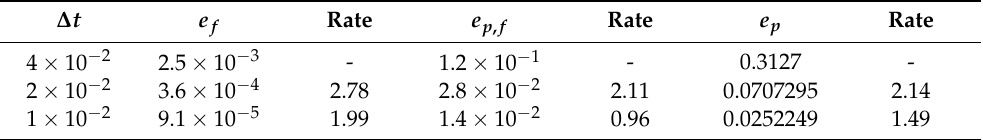
Table 3. Temporal convergence test for variables u f , p f , and u p .